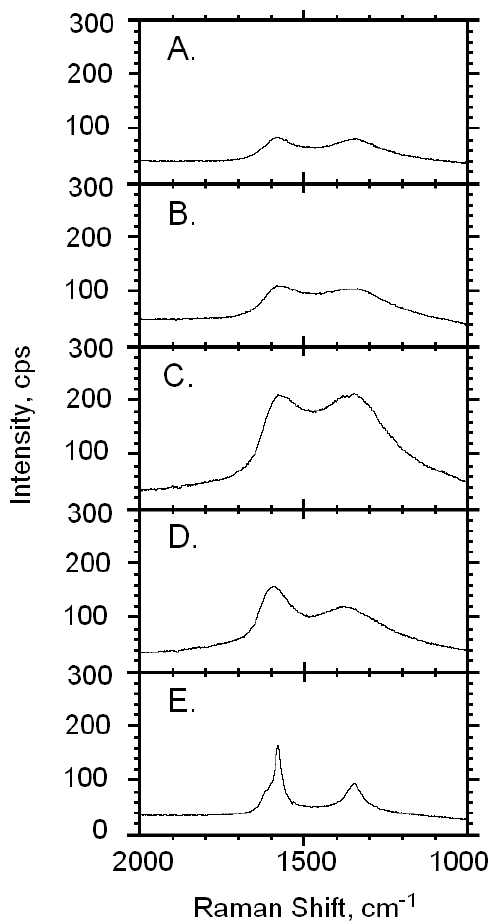
Fig. 8. Raman spectra of reference materials including soot gen- erated by burning propane gas in our laboratory (A) , Fluka humic acid (B) , Pahokee peat humic acid (C) , Leonardite humic acids (D) , and graphite (E) are